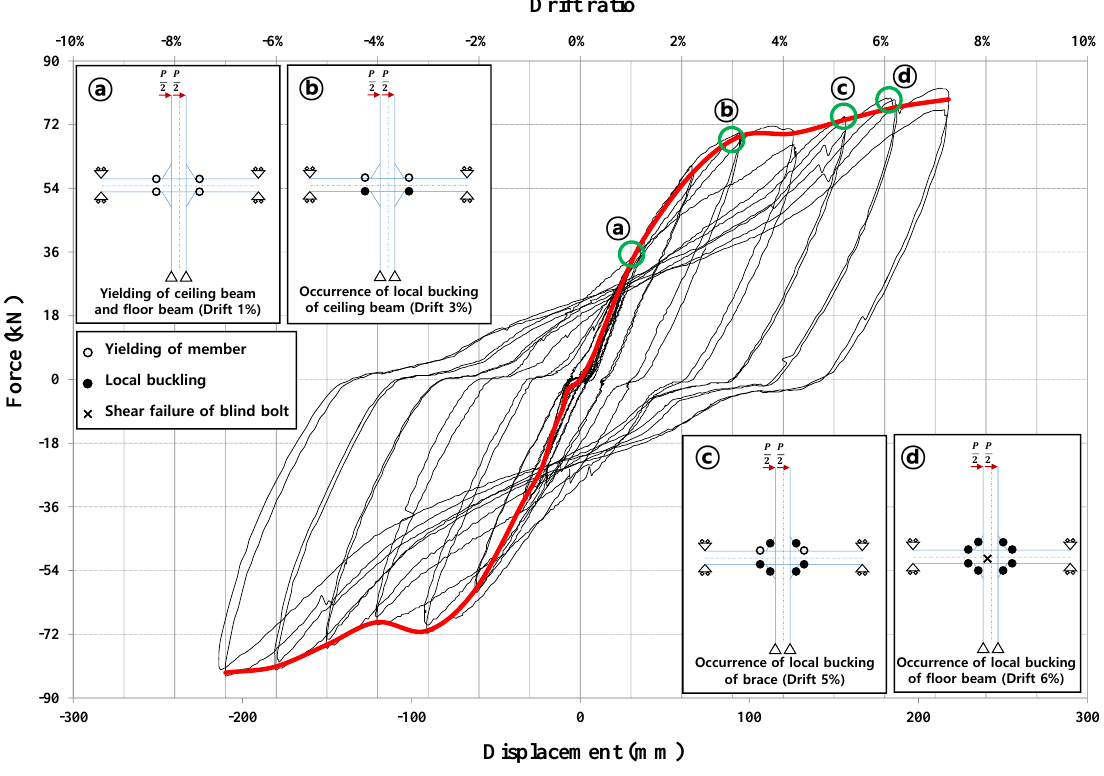
Figure 13. Hysteresis and backbone curves of specimen IC_OB_B.